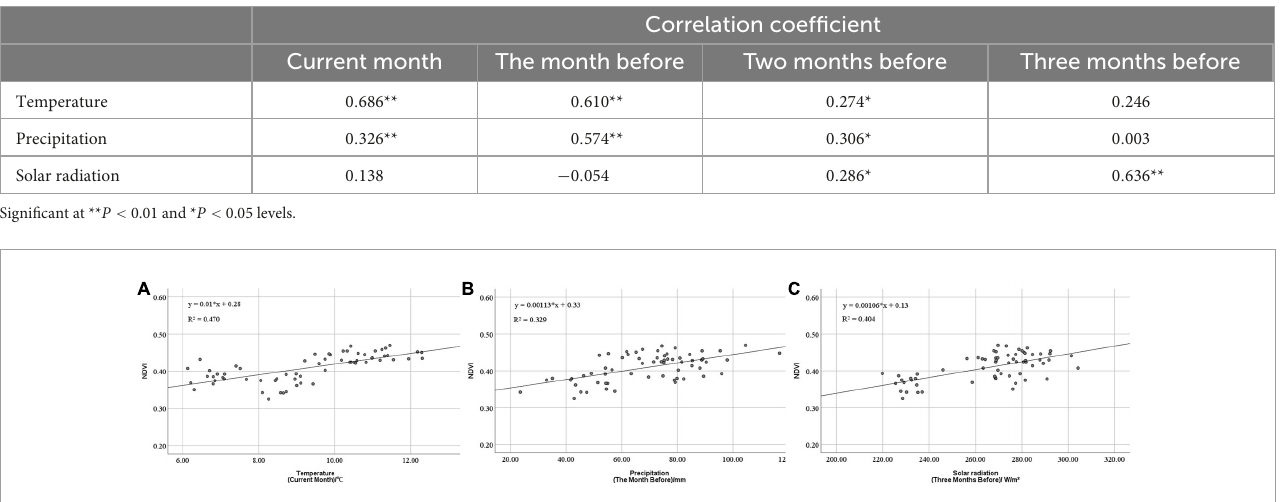
FIGURE6 Relationship between the growing season normalized difference vegetation index (NDVI) of wetlands and climate in the TP from 2000 to 2015: (A) normalized difference vegetation index (NDVI) and temperature (the current month); (B) NDVI and precipitation (the month before); (C) NDVI and solar radiation (the 3 months before).